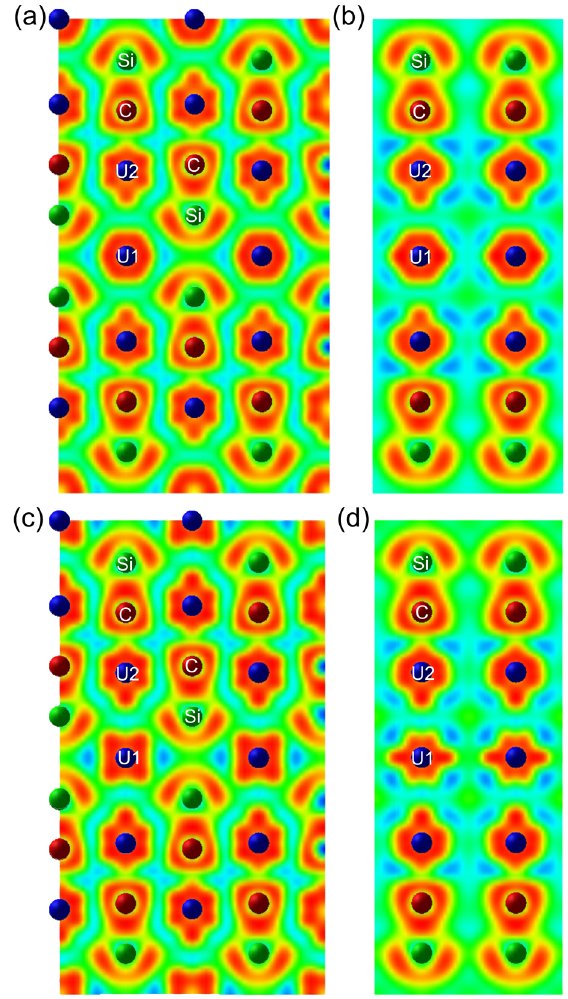
Figure 8. The electron localization function slice ( a ) along the [110] plane at 0 GPa; ( b ) along the [100] plane at 0 GPa; ( c ) along the [110] plane at 12 GPa; and ( d ) along the [100] plane at 12 GPa .